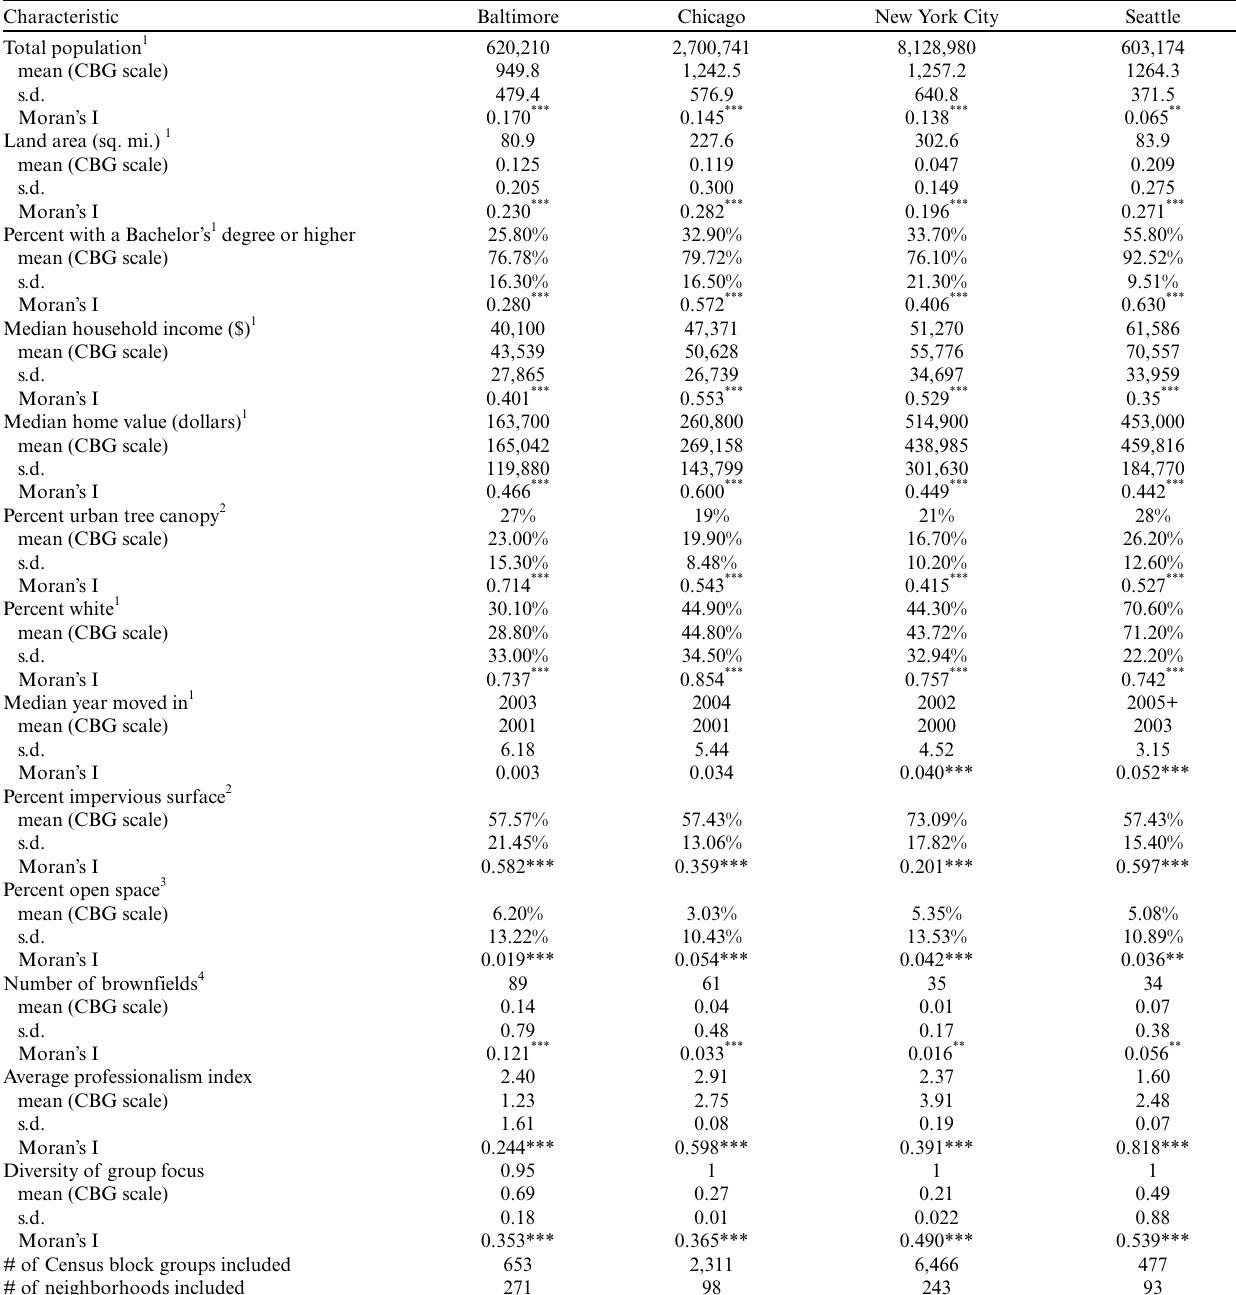
Table 1 . Socioeconomic and environmental characteristics of cities included within the four study areas. Citywide totals on top with Census block group (CBG) means, standard deviation (s.d.), and Moran’s I